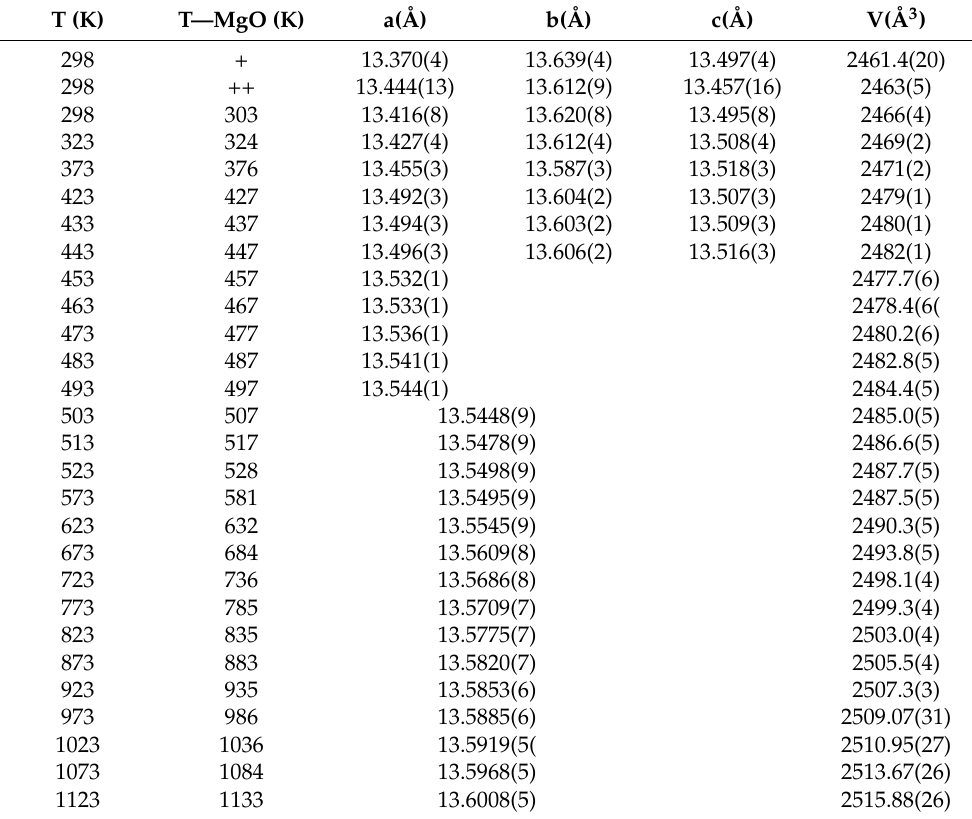
Table 4. Variation of lattice parameters with calibrated temperatures for Rb 2 CoSi 5 O l2 .